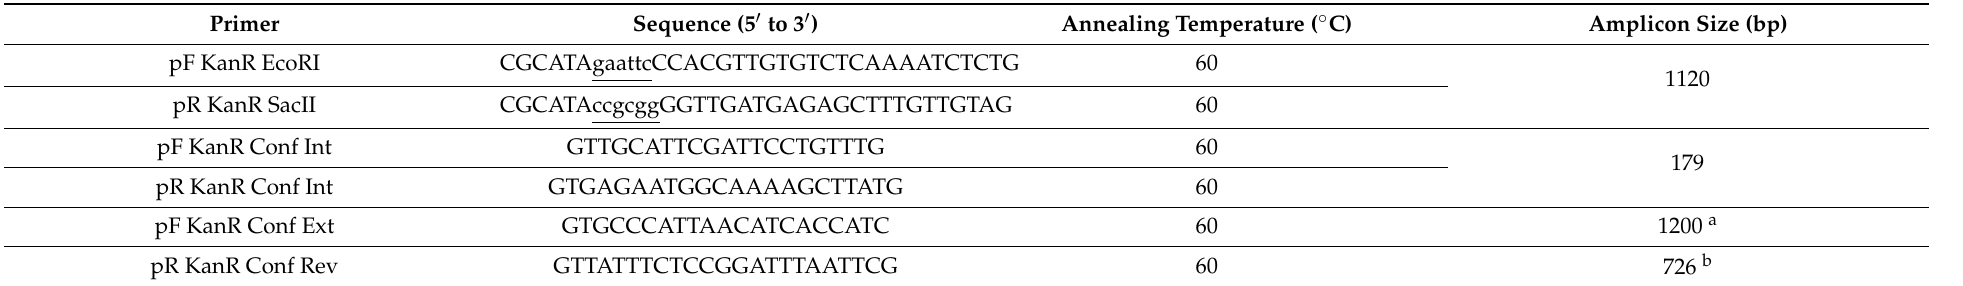
Table 2. List of primers and expected size of polymerase chain reaction products used in this